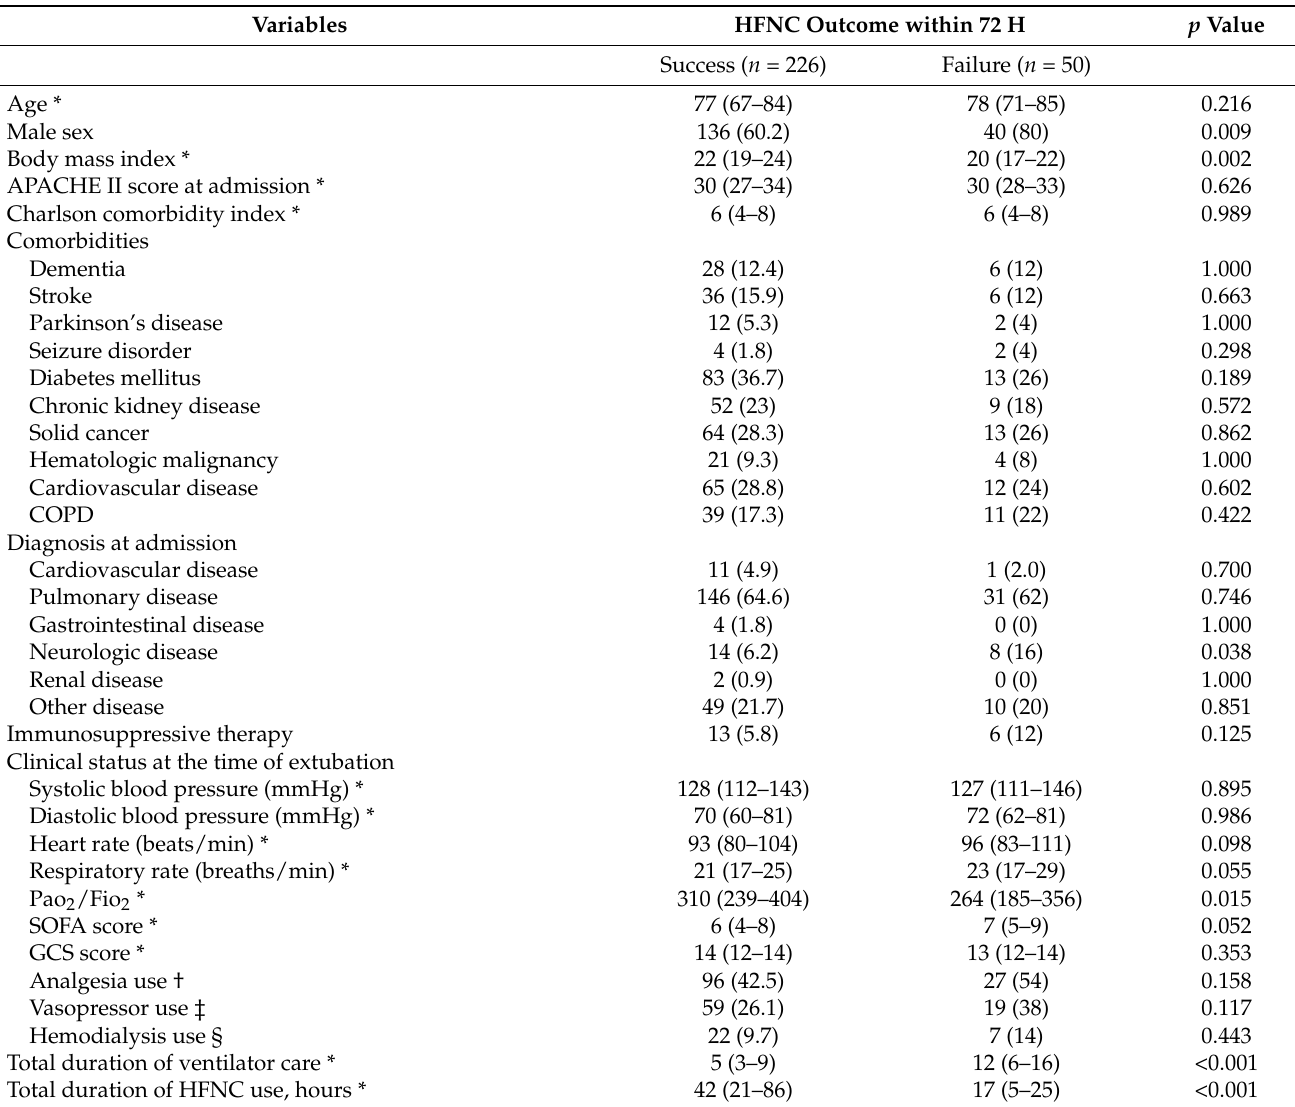
Table 1. Clinical characteristics of patients in this